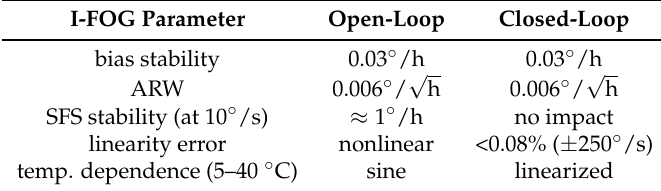
Table 1. The parameters of the tested I-FOG prototype in the open-loop and closed-loop